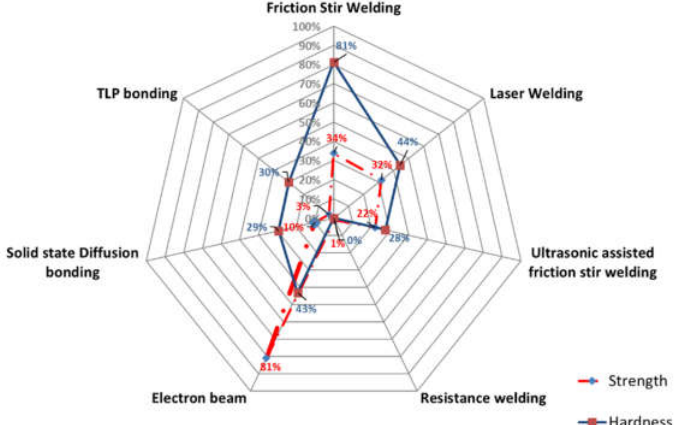
Figure 1. Spider diagram showing the relative joint strength and hardness for dissimilar joints produced by the different welding processes. Table 1. Recent studies on dissimilar joining of Ti alloy utilizing di ff erent